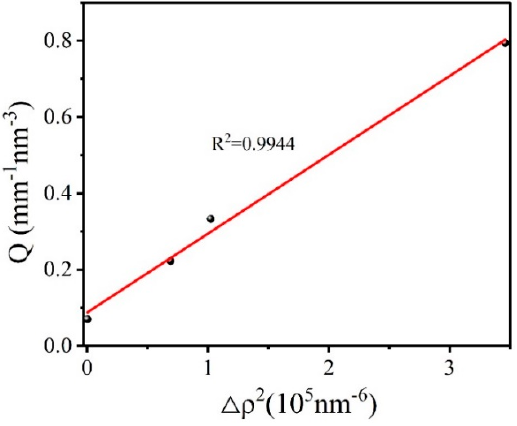
Figure 3. Scattering invariant Q for HMX crystal as a function of electron density difference.